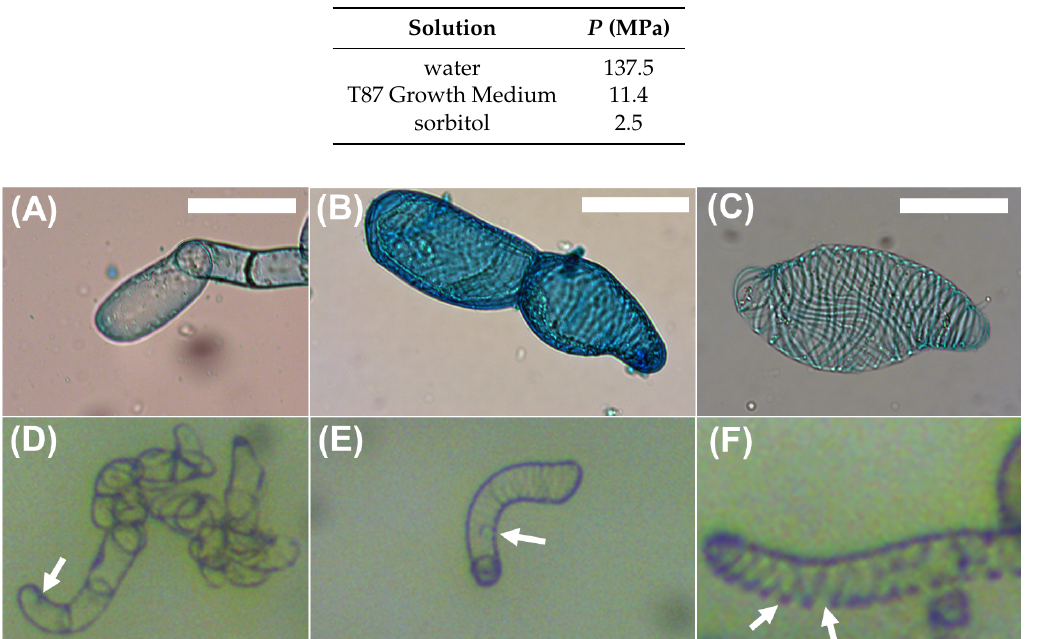
Table A3. Osmotic pressure calculated for each of the three solutions used for mechanical testing.